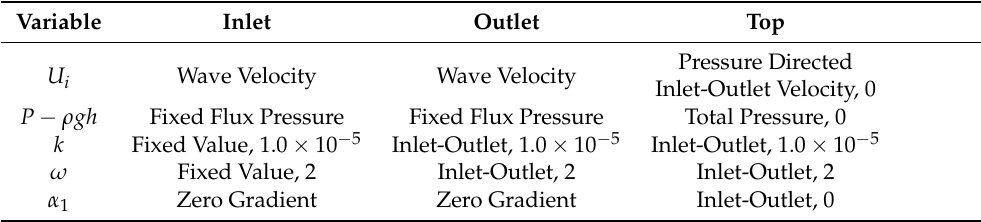
Table 3. Boundary conditions and prescribed values for the inlet, outlet, and top patches. Variable